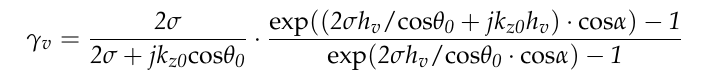
Figure 7. Images of the four forest stands ʹ terrain slope and DEM. ( a – d ) Pauli ‐ basis of four stands in the SAR coordinate system. ( e – h ) Terrain slope ( i – l ) DEM. The hybrid iterative algorithm is modified at this point to use the terrain ‐ corrected three ‐ stage inversion method 0 ThreeStage to replace the first term of the theoretical model. The vertical wavenumber k was corrected to reduce the impact of terrain on the SINC 0 z inversion method (Equation (18)).